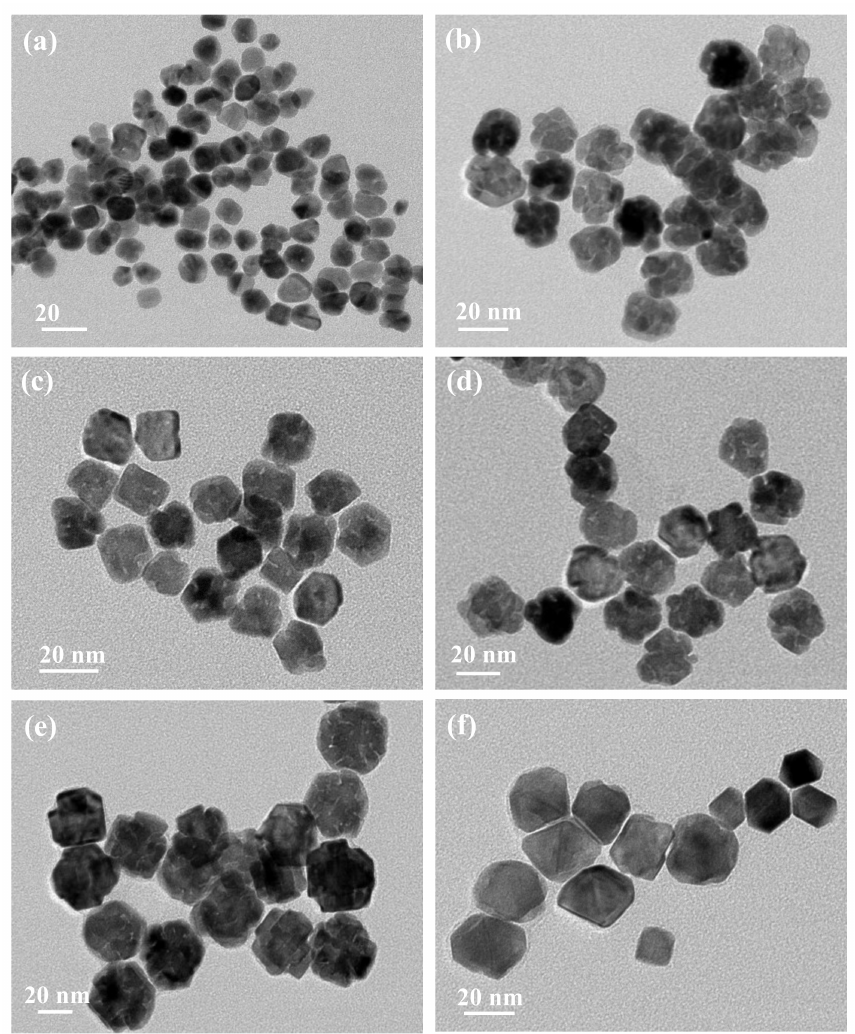
Figure 4. TEM images of Pt–Pd nanoparticles prepared by adding precursors with different ratios: ( a ) 10:1, ( b ) 9:1, ( c ) 7:1, ( d ) 5:1, ( e ) 3:1, ( f )